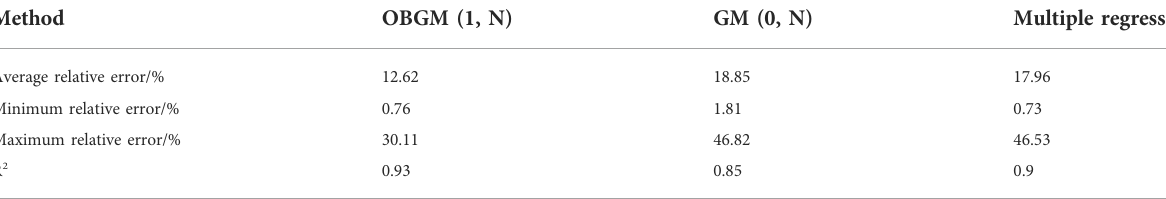
TABLE 6 Comparison of the application effect between different